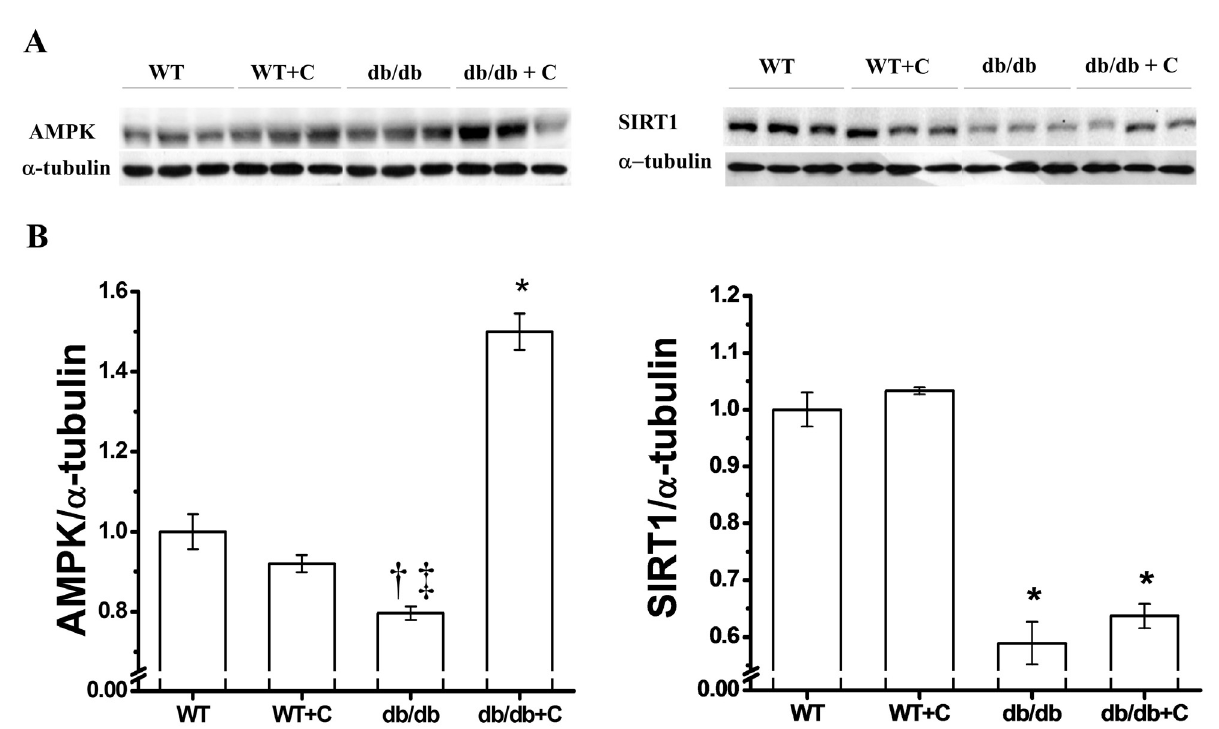
Figure 3. Effect of curcumin on AMPK and SIRT1 expression in liver. ( A ) Representative western blot of the AMPK and SIRT1 expression ( B ) Densitometry analysis of the AMPK/ α -tubulin and SIRT1/ α -tubulin ratios. * AMPK vs. WT, WT+C y db/db, p <